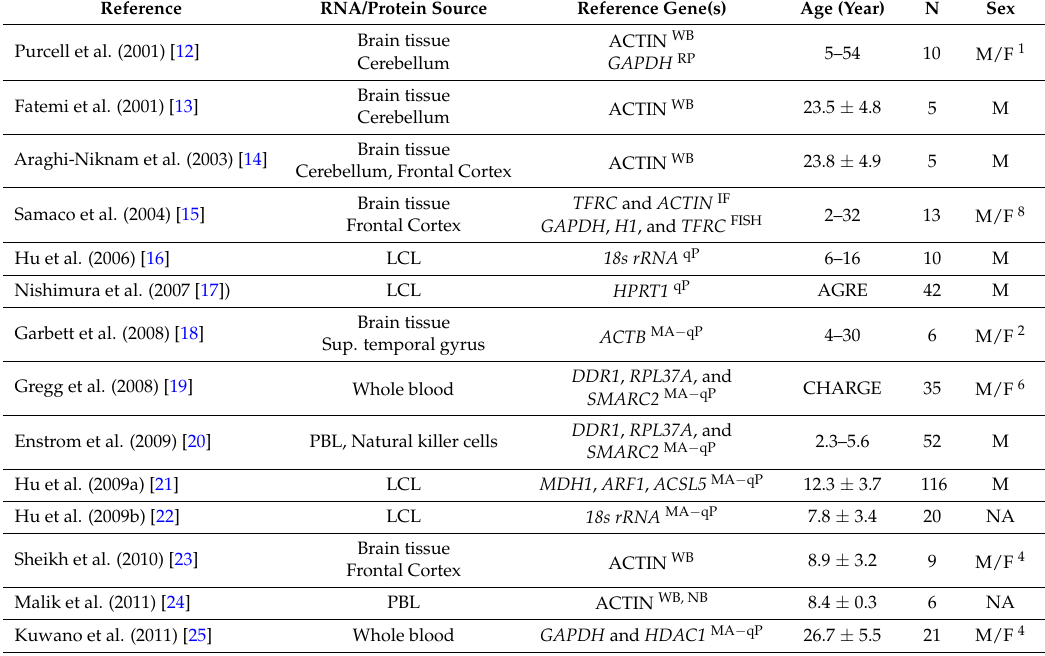
Table 1. Internal control genes used in ASD gene expression